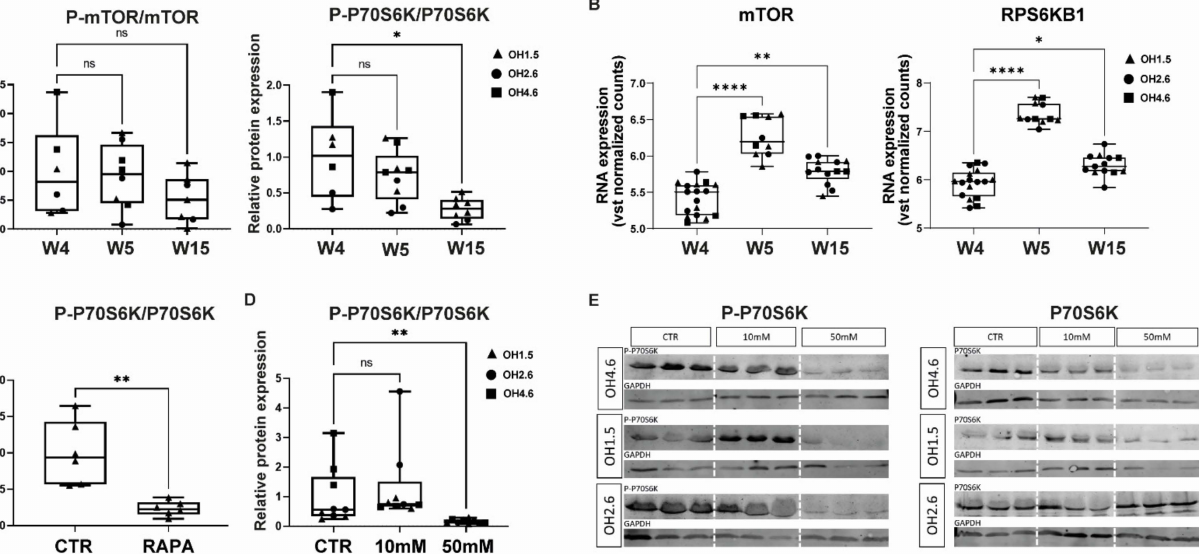
Figure 2. Baseline mTOR pathway expression and response to rapamycin and AA exposure in cere- bral organoids. ( A ) Quantification of Western blots for the mTOR–phospho-mTOR (P-mTOR/mTOR) ratio and the P70S6K–phospho-P70S6K (P-P70S6K/P70S6K) ratio in CTR organoids at different time points (week 4, week 5, and week 15). ( B ) mTOR and P70S6K gene expression in CTR organoids show- ing differences in DESeq2 vst log-transformed raw counts at different time points (week 4, week 5, and week 15). ( C , D ) Quantification of Western blots for ( C ) P-P70S6K/P70S6k ratio in rapamycin-exposed organoids and ( D ) P-P70S6K/P70S6k ratio in acutely AA-exposed (10 mM/50 mM) organoids. ( E ) Western blots of acutely AA-exposed cerebral organoids lysates quantified in ( E ). Three sam- ples per condition for 3 cell lines were used. Western blots were cropped to show the relevant bands (P70S6K, P-P70S6K, and GAPDH). Boxplots display median and IQR, with whiskers from minimum to maximum values. Data points represent individual organoids from different cell lines (circles = OH2.6; triangles = OH1.5; squares = OH4.6). Data were analyzed with the Kruskal–Wallis tests with Dunn test for multiple comparisons. Significant differences compared to W4 (for ( A , B )) and to CTR (for ( D )) are indicated with * p < 0.05; ** p < 0.01, **** p < 0.001. Mann–Whitney test was used to compare rapamycin treatment to CTR condition (** p <